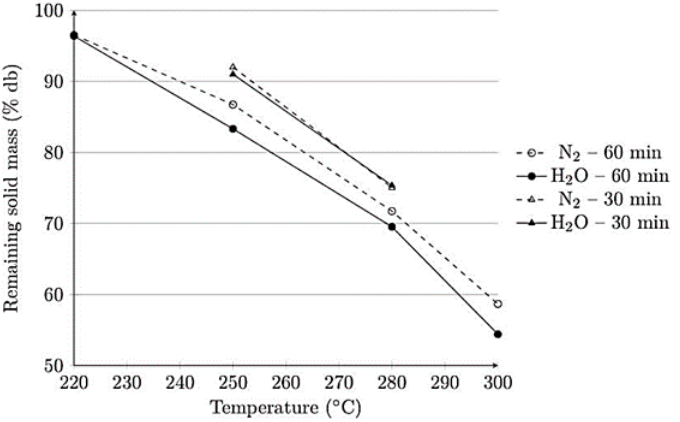
Figure 8. Remaining solid mass for beech wood chips in torrefaction in function of temperature, duration of the plateau and gaseous atmosphere (100% v/v N 2 or H 2 O).